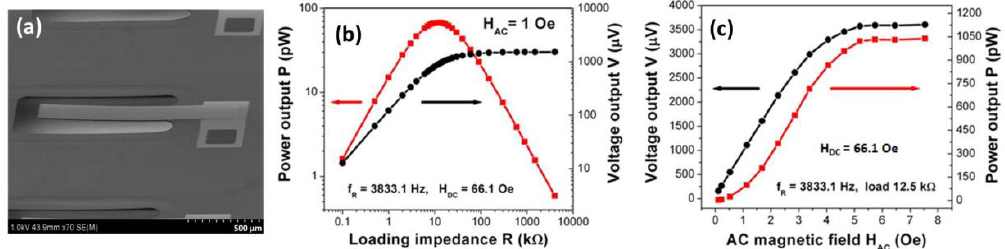
Figure 14. ( a ) SEM micrograph of a thin film ME energy harvester based on PZT/FeGa and ( b,c ) its energy harvesting properties [101].